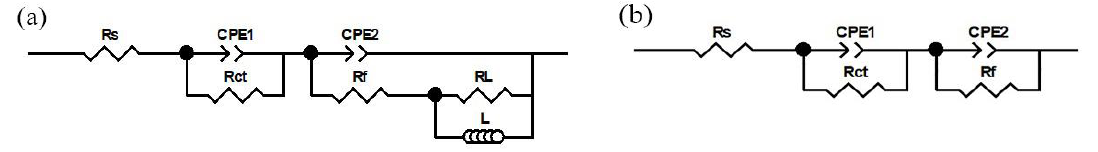
Figure 8. Impedance plots of the extruded Mg–7Li–3Al–xCa alloys immersed in a 3.5 wt.% NaCl Table 6. Fitted results of the EIS measurement of the extruded Mg–7Li–3Al–xCa alloys using the solution. ( a ) Nyquist plots, ( b ) Bode plots, ( c ) Phase angle diagram. equivalent circuits shown in Figure 9.